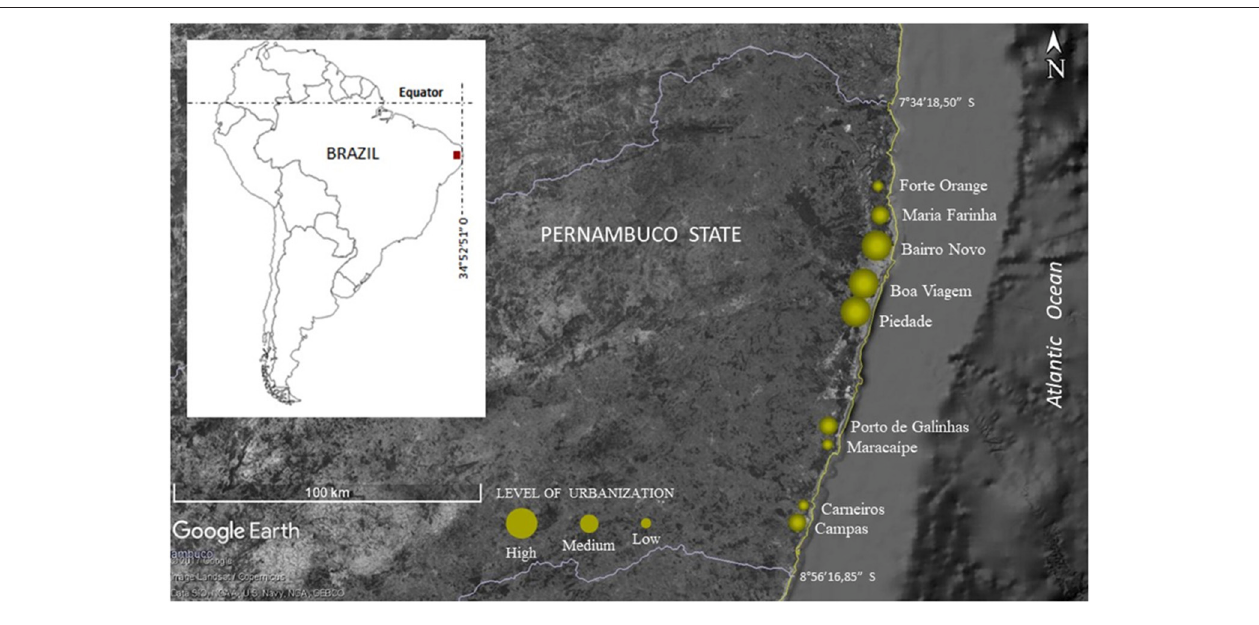
FIGURE 1 | Location of the analyzed beaches and level of urbanization.